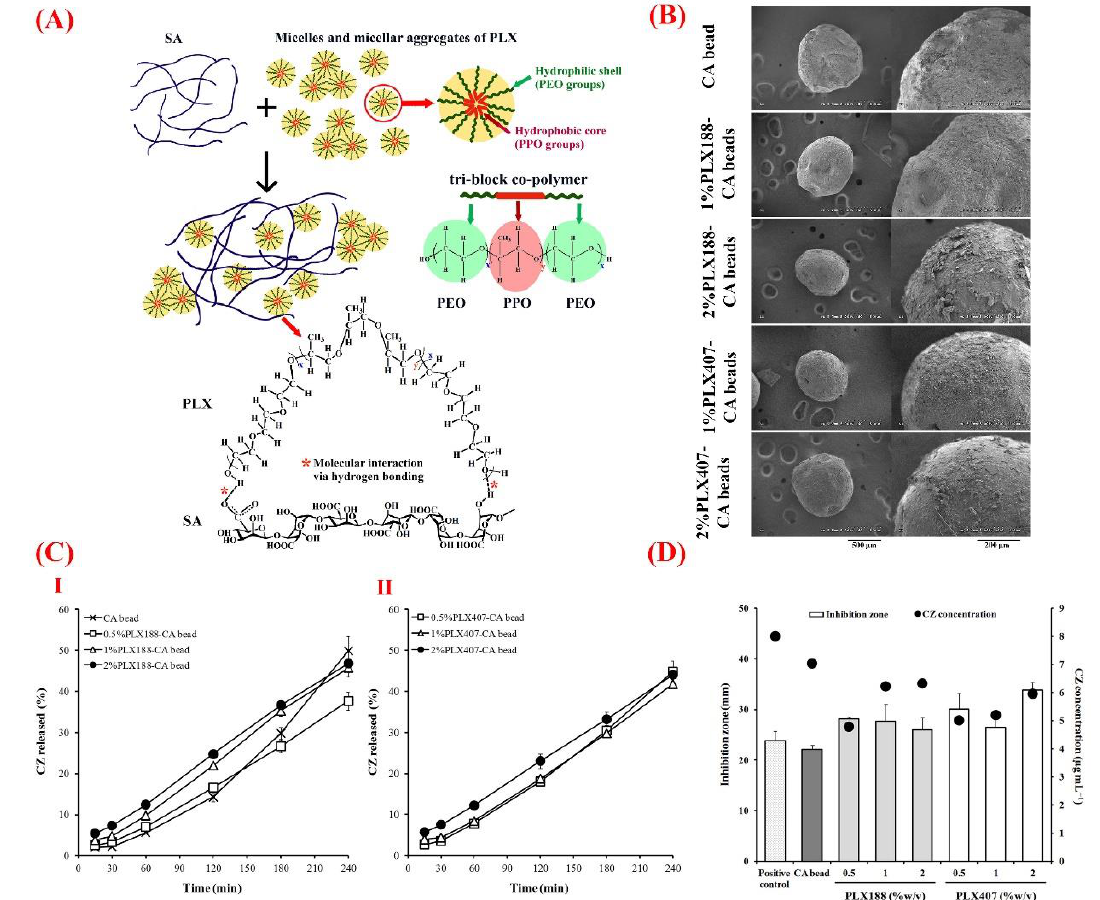
Figure 4. ( A ) Schematic illustration of the molecular interaction between sodium alginate (SA) and poloxamer (PLX), in which carboxyl and hydroxyl groups of SA via hydrogen bonding interact with the hydroxyl groups of PLX. ( B ) Scanning electron microscopy (SEM) showing the surface morphology of calcium alginate (CA) and PLX–CA beads containing clotrimazole (CZ). ( C ) The release profile of CZ from (I) CA and PLX188–CA beads and (II) PLX407–CA beads. ( D ) The graph exhibiting anticandidal activity of CZ released from CA and PLX–CA beads. Reproduced with permission from Reference [125].